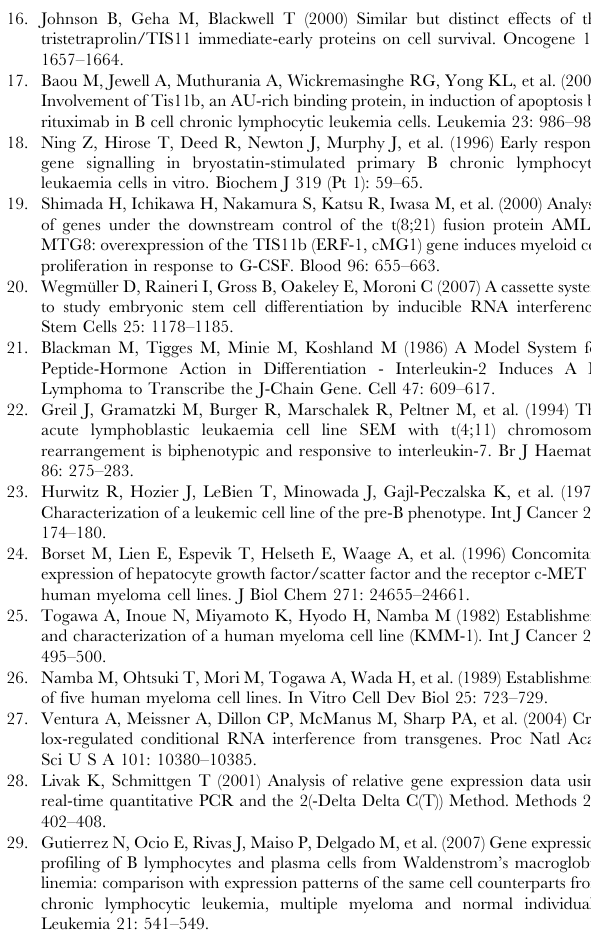
Table S2 BLIMP1 target genes inferred from ARACNe analysis. The Bonferroni-corrected P values (P= # 0.05) for the significance of up-regulation in normal B cells are shown. Known BLIMP targets were taken from the SignatureDB [37,41]. Table S3 ZFP36L1 targets inferred from ARACNe analysis. Values of the false discovery rate (FDR= # 0.01) for enrichment in normal plasma cells are shown. Data on the presence and type of ARE element were taken from the ARED database [49]. Table S4 Enrichment of Gene Ontology terms for ARACNe- inferred ZFP36L1